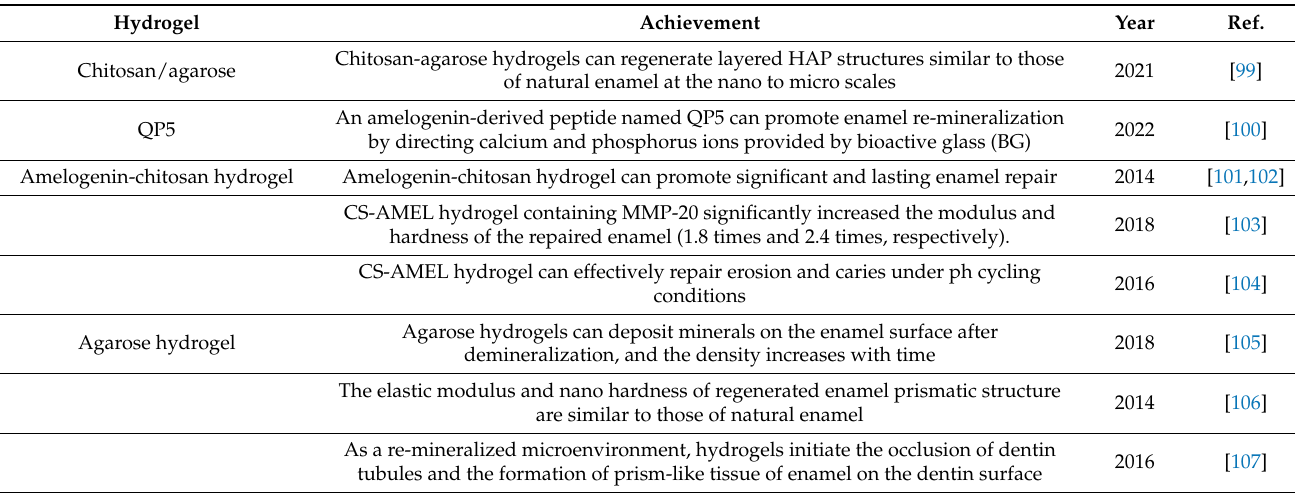
Table 4. Application of hydrogel in mineralization of